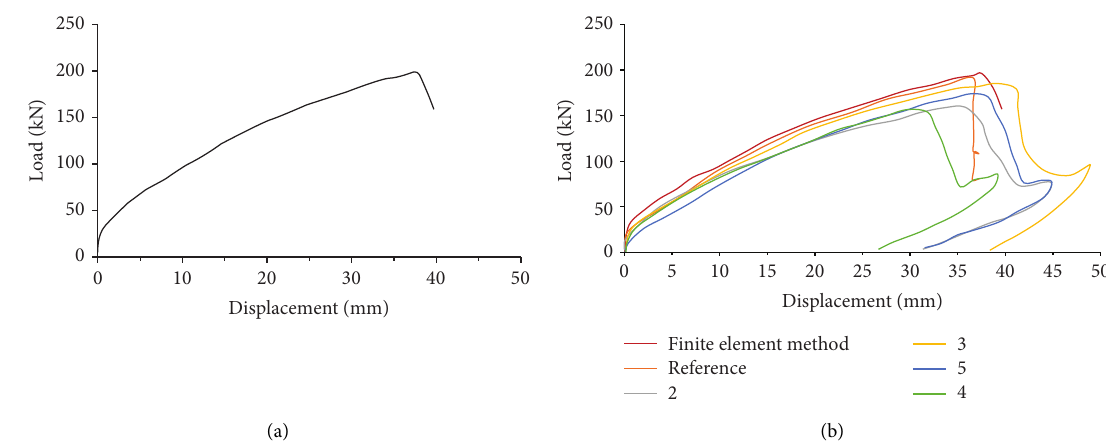
Figure 6: Comparison of the force-displacement response of the finite element method (in red) with the experimental method. (a) FEM result. (b) Experiment result [33].